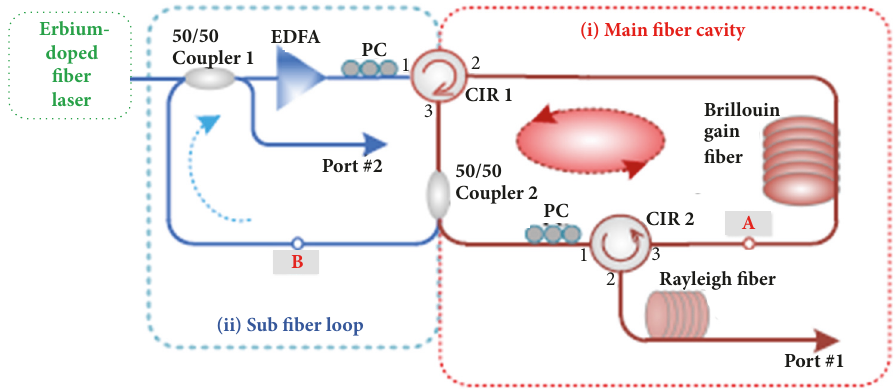
Figure 12: (i) Main fiber cavity: Optical circulator 1, Brillouin gain SM fiber, another circulator combining with Rayleigh feedback fiber (5- km) with continuouslychangingcorediameterand dispersion for enhancedRayleighDFB.(ii) Fibersubloop :EDFA amplifies eachbackward Stokes wave [adapted from